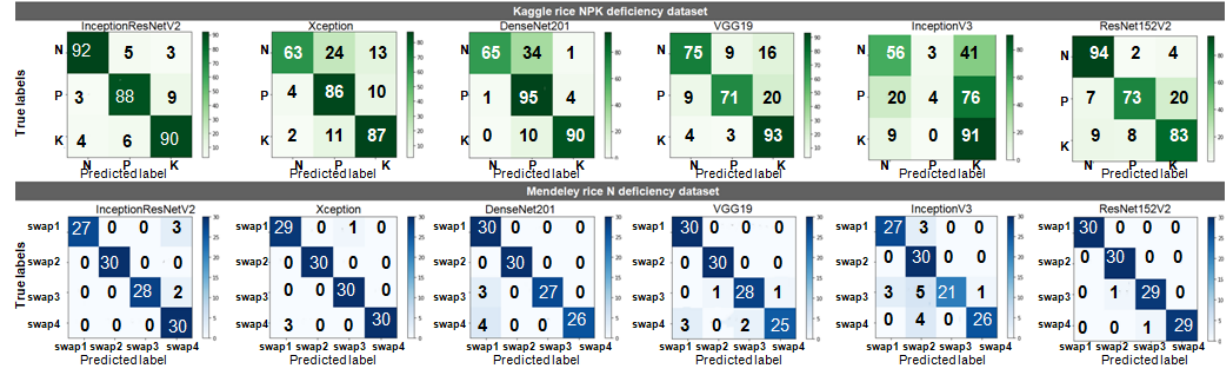
Figure 7. Validation accuracy versus number of epochs.